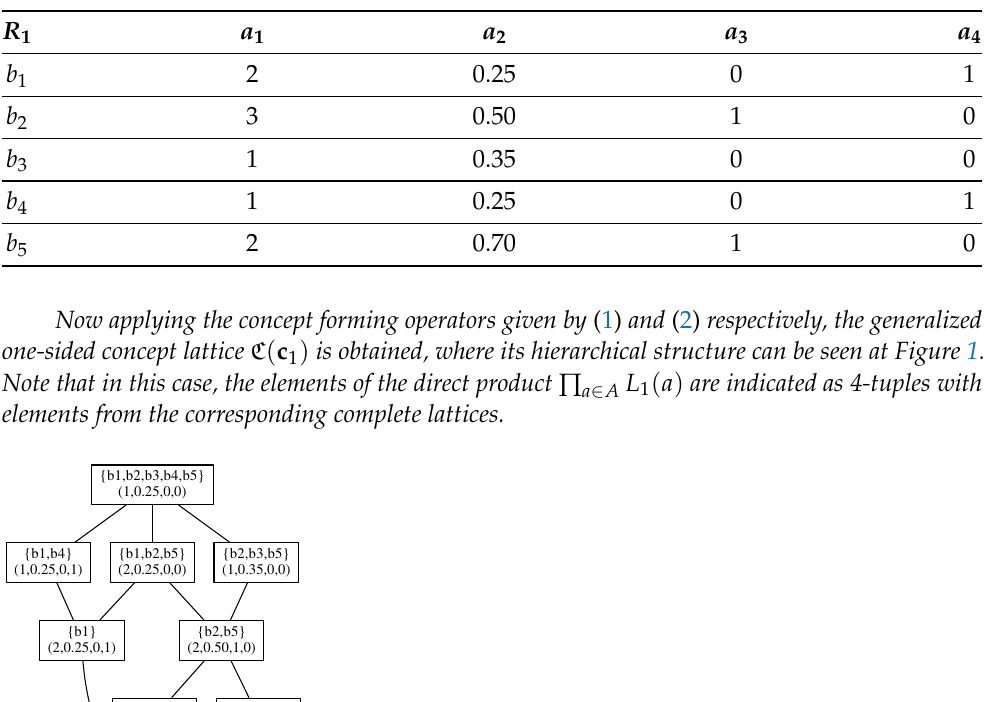
table, represented by the generalized incidence relation R 1 is given in Table 1. Table 1. Input data table corresponding to the relation R 1 .